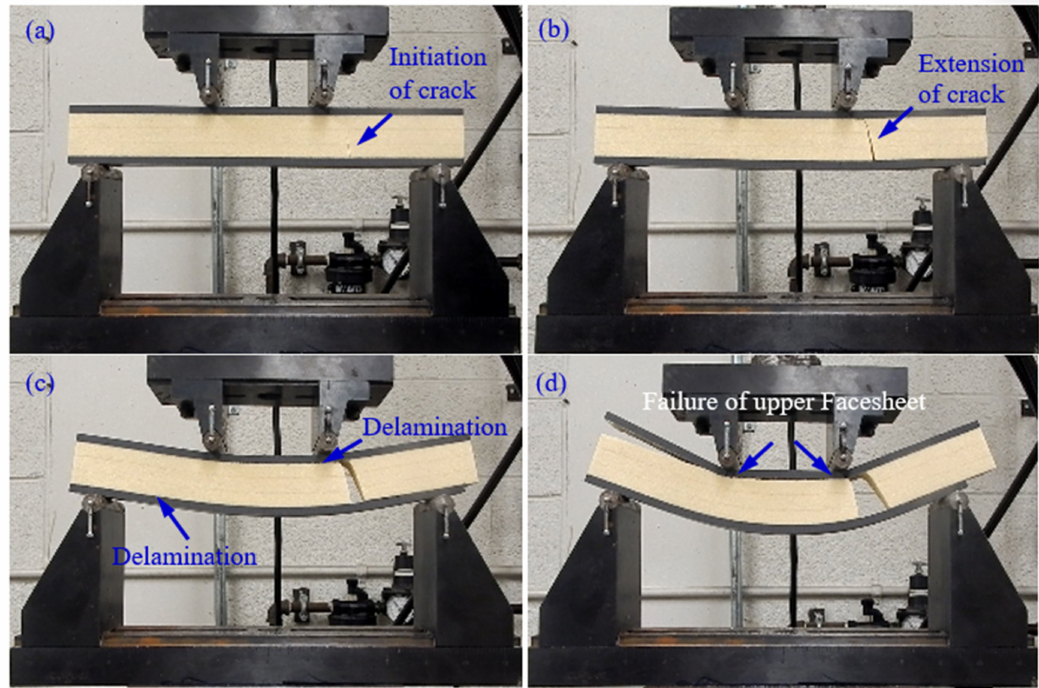
Figure 4. Damage morphologies of a CFRP / PU foam sandwich beam with a thick core under four-point flexural loading: ( a ) Initiation of crack; ( b ) Crack Extension; ( c ) Delamination; ( d ) Upper Facesheet Failure.